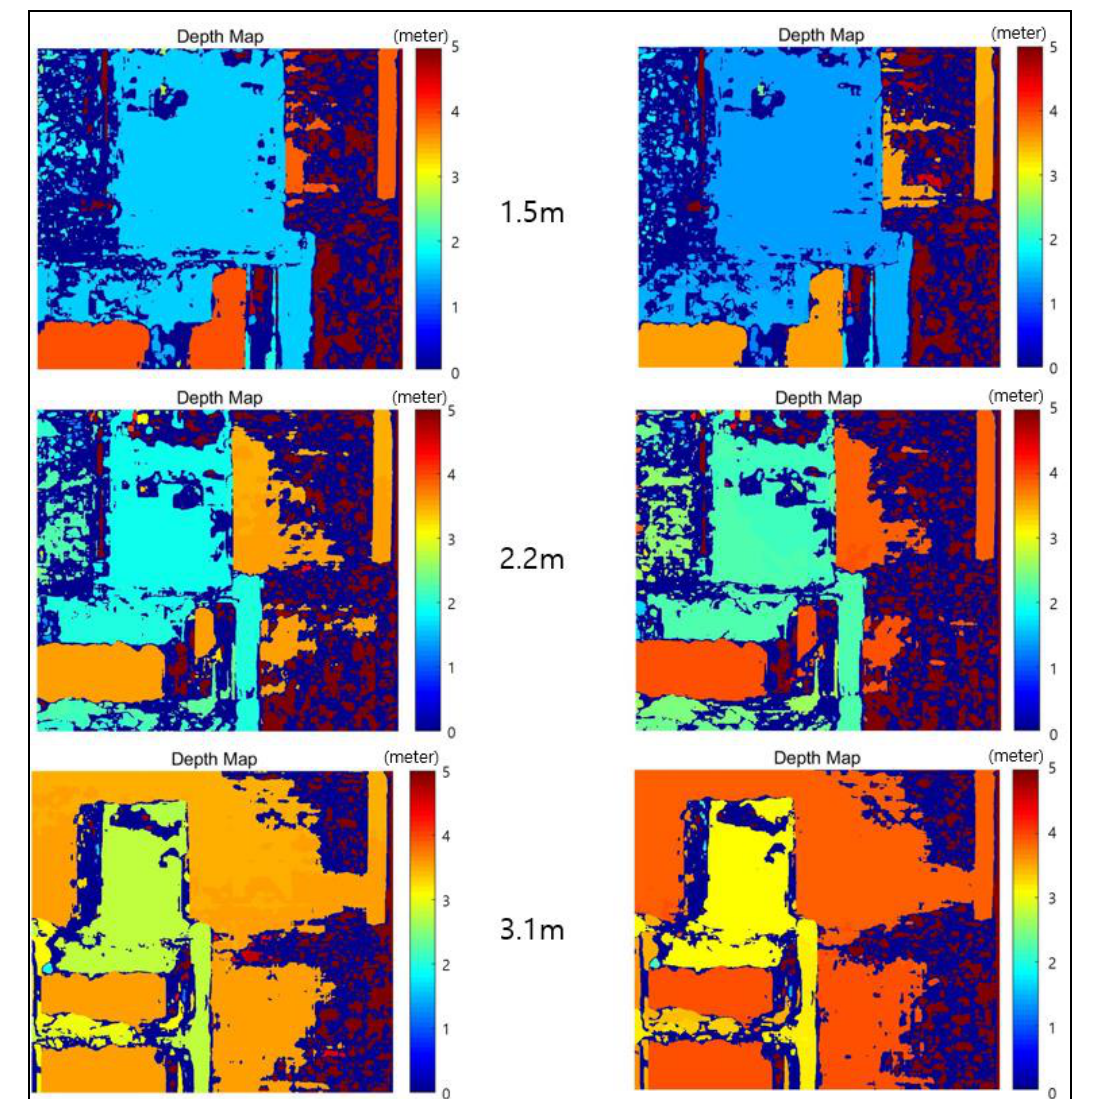
Figure 24. The generation of the depth map of Zhang’s algorithm and proposed algorithms.